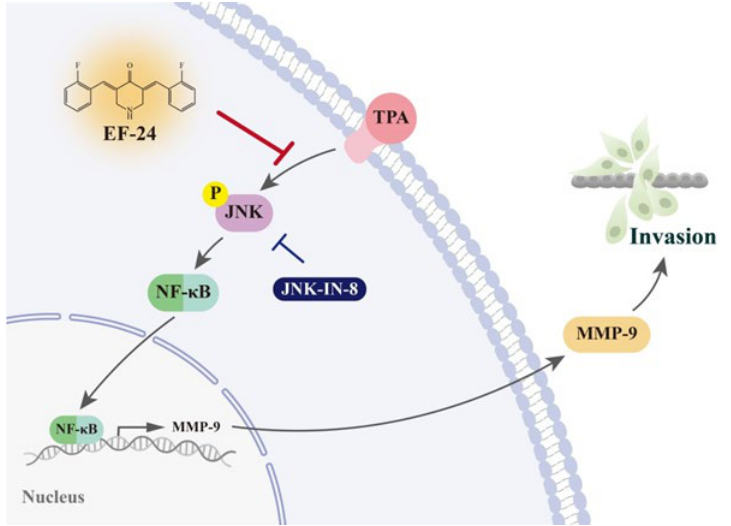
Figure 7. A schematic diagram of EF-24 in the regulation of TPA-induced NPC invasion.